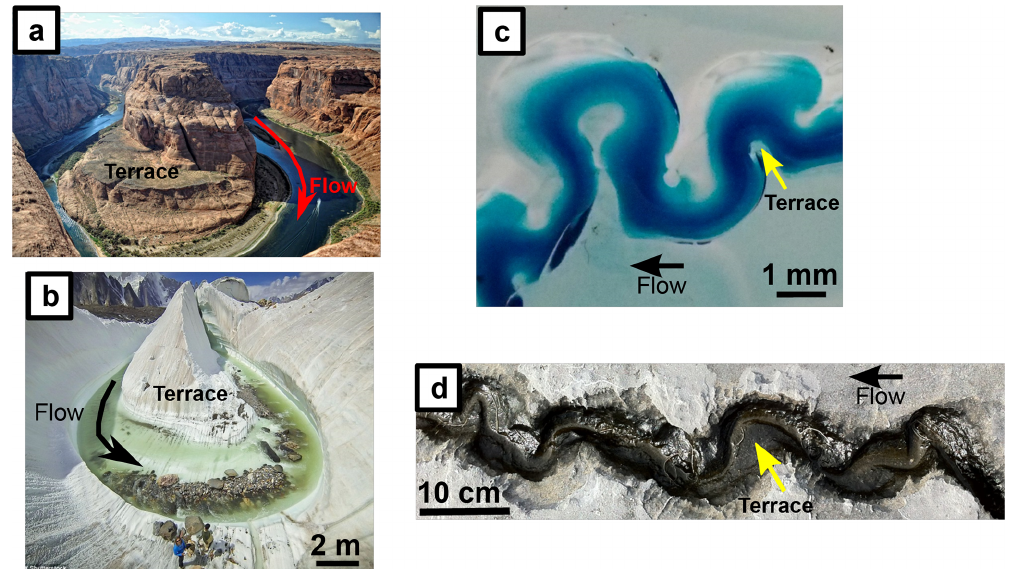
Figure 7. Bend skewness and terrace in (a) a bedrock river, (b) a supraglacial meltwater meandering channel, (c) a self-formed millimeter- scale laboratory meltwater meandering channel, and (d) soluble limestone (meanderkärren). Image information: (a) Horseshoe bend, Ari- zona; source: Hermans (2021). (b) Concordia, Pakistan; source: David Kaszlikowski. (c) Source: this study. (d) The Burren, Ireland; source: Stephen Marshak.